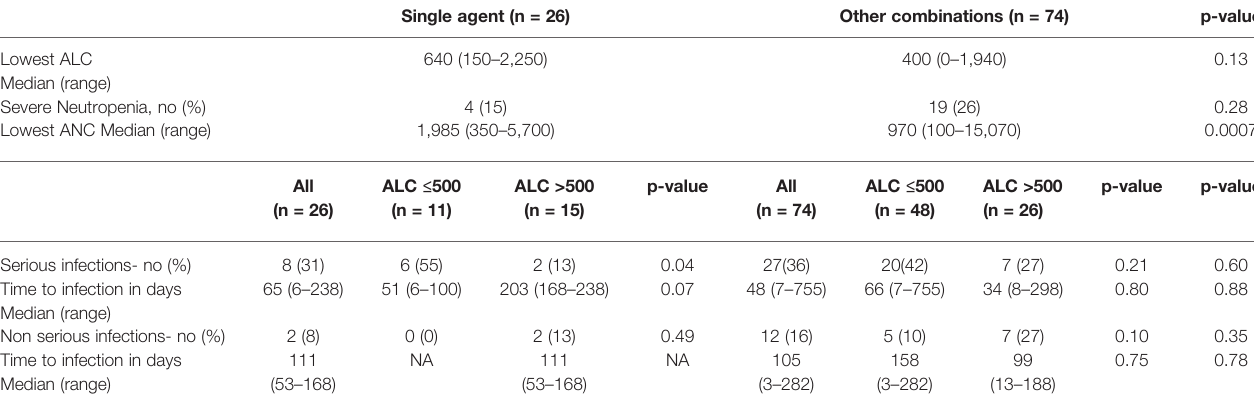
TABLE 3 | Lymphopenia, neutropenia, and infectious characteristics in patients treated with single agent daratumumab (n = 26) or combination (n = 74). Single agent (n =